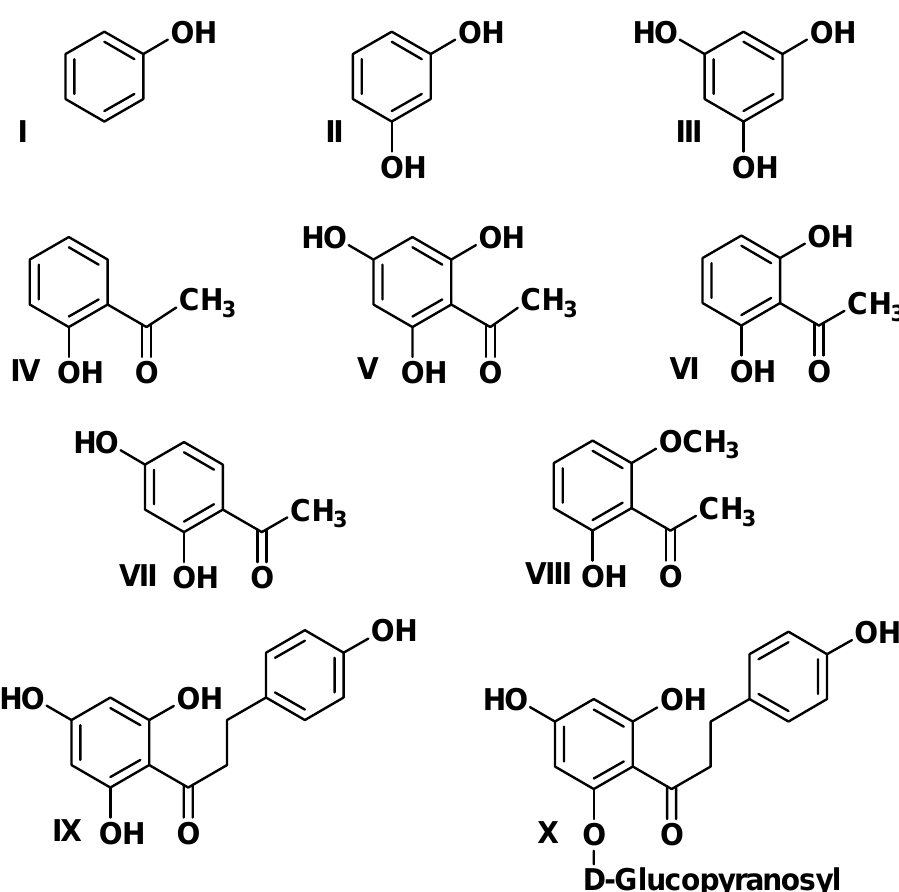
Figure 2. Structure of dihydrochalcones and related